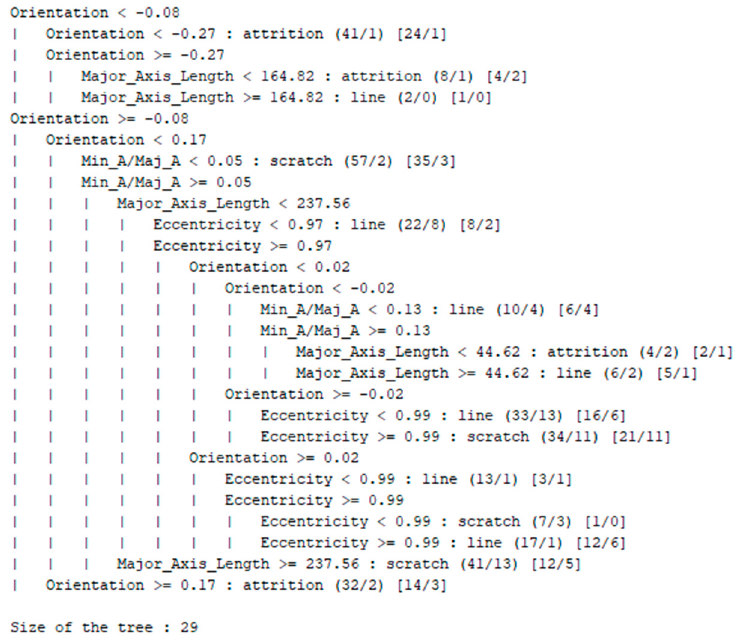
Figure A1. The pseudo-code showing the classification tree obtained by the REPTree algorithm.